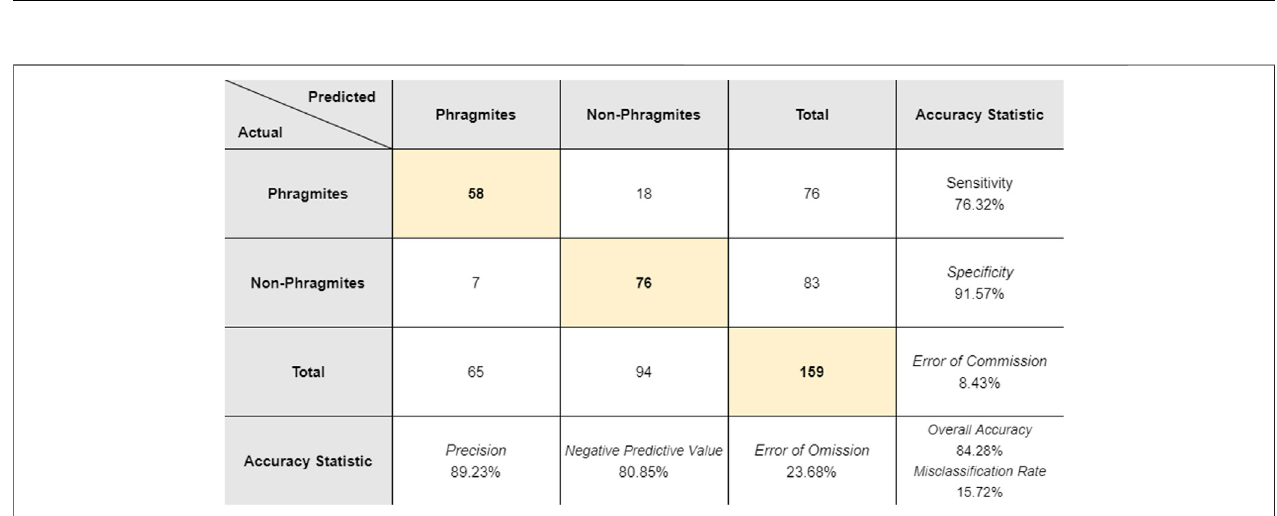
FIGURE8| Thefrequencydistributionsforthesizesof Phragmites polygonspresentinthe fi nalmap.Themajorityofpolygons(1,620outof2,037)werebetween0 and 100 m 2 : the subset histogram shows the detailed frequency distribution of polygon sizes within this range.